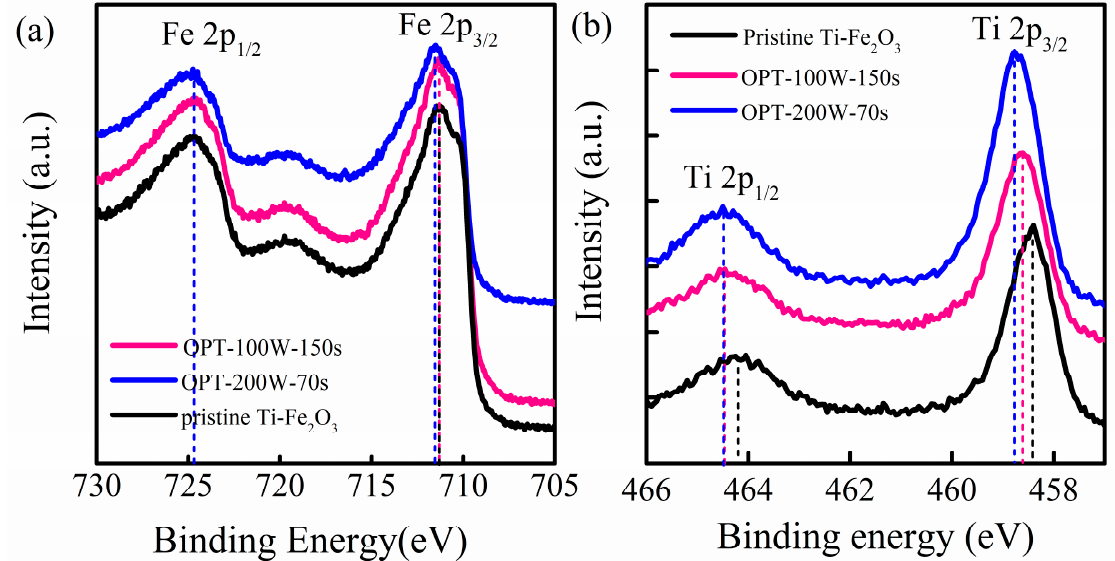
Figure 5. X-ray photoelectron spectroscopy analysis: ( a ) Fe 2p peaks and ( b ) Ti 2p peaks of OPT-100W-150s, OPT-200W-70s, and pristine Ti-Fe 2 O 3 samples, respectively. Table 2. The listed binding energy values of Fe, Ti, and O elements in X-ray photoelectron spec-